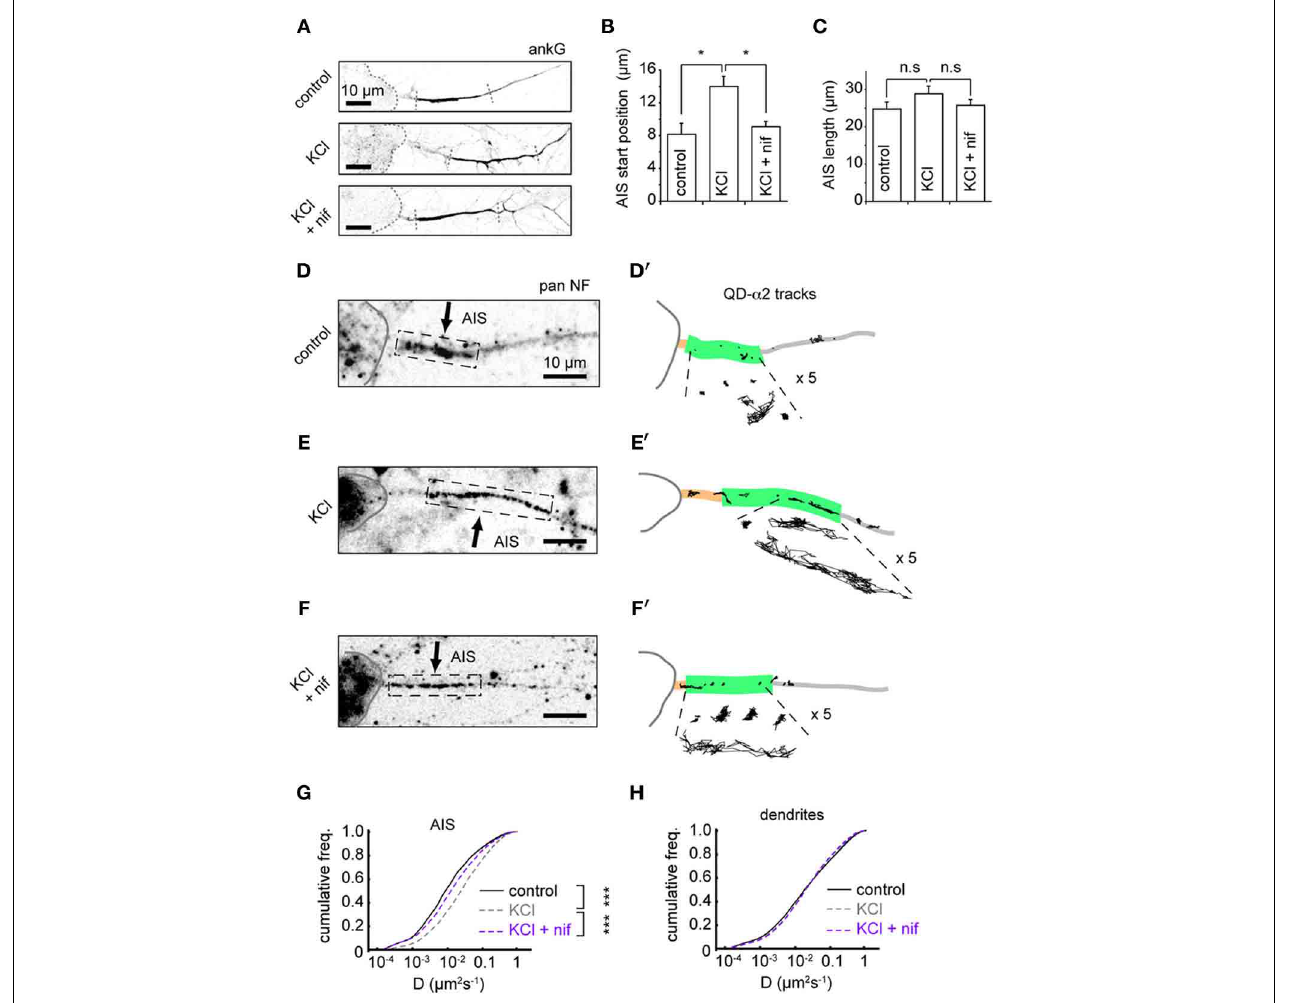
FIGURE 5 | Distal shift in AIS position and increased GABA A R lateral mobility depend on L-type VGCCs. (A) Example ankG staining from control (top), KCl (middle) and KCl + 5 μ M nifedipine conditions (bottom). (B) Analysis of AIS start position. One-way ANOVA omnibus test p = 0 . 01. Pairwise test p -values are Bonferroni-corrected. KCl treatment caused a distal shift in AIS start position ( p < 0 . 05), which was prevented by addition of nifedipine ( p < 0 . 05), n = 5 experiments (control = 150 cells, KCl = 132 cells and KCl + nif = 116 cells). (C) Analysis of AIS length. Omnibus p = 0 . 28. No change in AIS length was seen in either KCl or KCl + nifedipine ( p > 0 . 05 for both comparisons). (D,D (cid:2) ) Example control neuron with AIS location given by